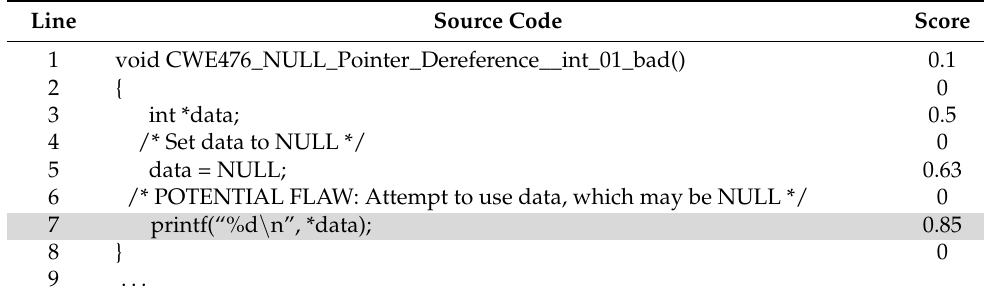
Table 1. Example analysis result of BERT-based line-level weakness analysis